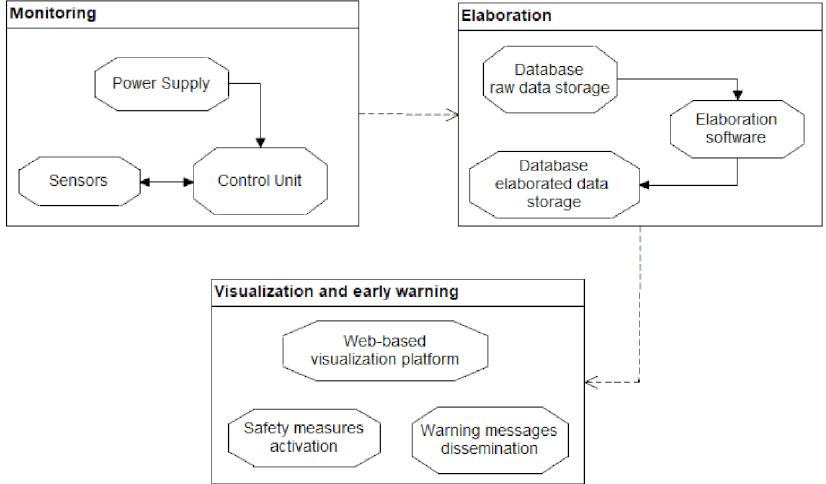
Figure 1. Internet of natural hazards (IoNH) approach applied to modular underground monitoring system (MUMS) system, with data collection, transmission, database storage, automatic elaboration, results representation, alarms